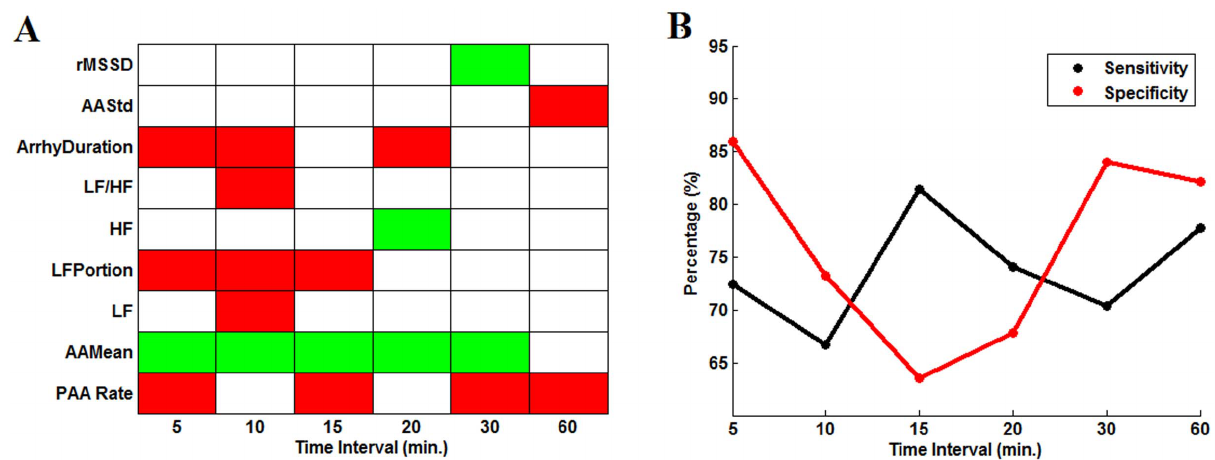
Figure 8. Results of logistic regression to discriminate trigger and non-trigger period. A) Results of the forward stepwise logistic regression using position data. Sign of estimated coefficient of predictors in the logistic model (red: positive coefficient, green: negative coefficient) for different partitions of 2 hours intervals before AF. B) Sensitivity (red, % of correct classification of the last interval) and specificity (black) of each model with cutting point calculated from the ROC curve.